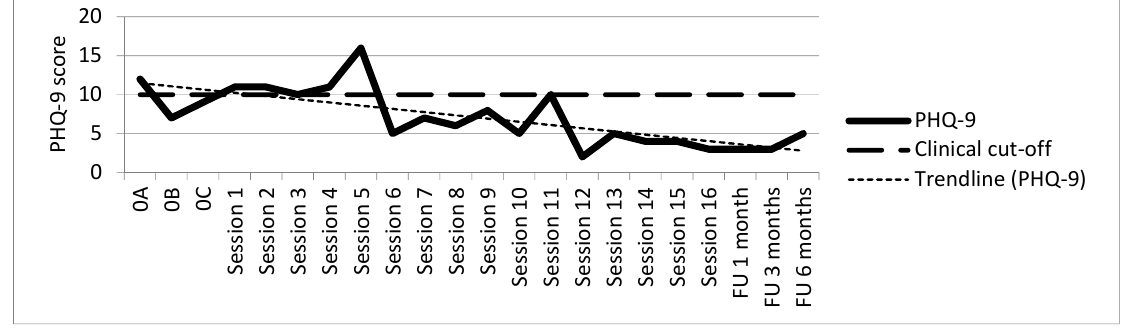
Figure 1: Deborah’s weekly depressive (PHQ-9) score Note . 0A, 0B, 0C and 0D = assessment sessions. PHQ-9 = Patient Health Questionnaire 9-item for depression (Spitzer, Kroenke & Williams, 1999). FU = follow-up.